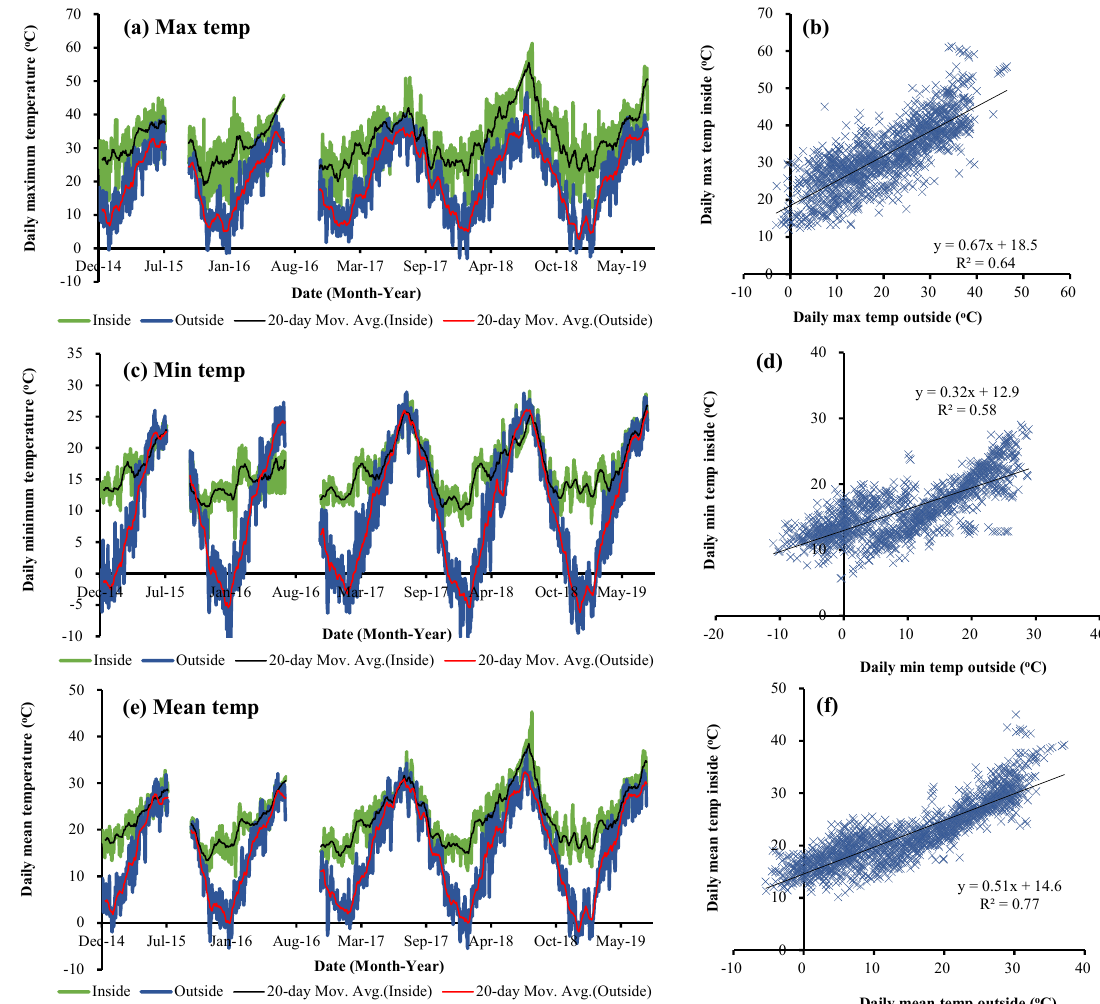
Figure 3. Daily maximum ( a , b ), minimum ( c , d ), and mean air temperature ( e , f ) inside and outside of the sunken solar greenhouse, respectively, during the seven seasons. The black and red thin solid lines on ( a , c , e ) represent the 20-day moving averages of the corresponding temperatures inside and outside, respectively.